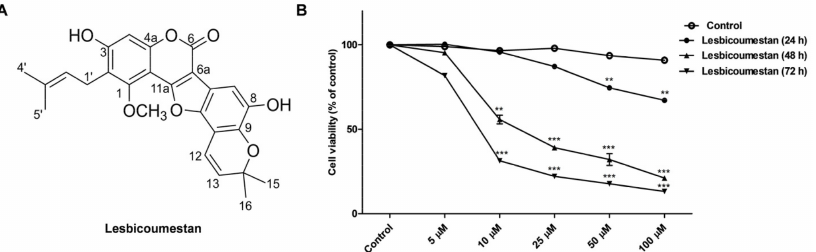
Figure 1. ( A ) Structure of lesbicoumestan. ( B ) Antiproliferative effects of lesbicoumestan on Jurkat